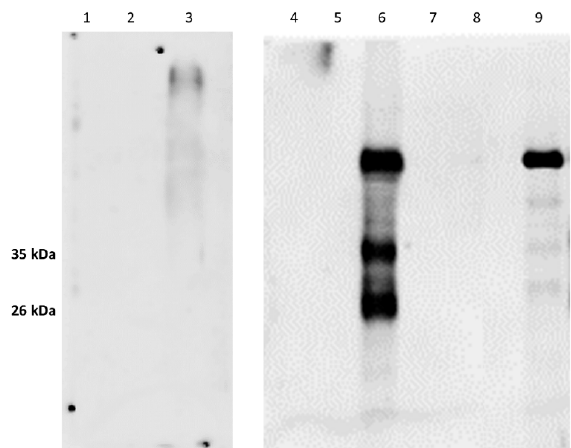
Figure 3. Results of WB analyses carried out with the anti-PrP MAb F89/160.1.5 on the pellets obtained after ultracentrifugation of brain tissue samples from one goat (lanes 1–3), as well as from a B. ceti -infected striped dolphin stranded along the Italian coast of Apulia (lanes 4–6) and from one lamb (lanes 7–9). The typical 35 kDa and 26 kDa PrP c bands are shown at lanes 3, 6 and 9 after ultracentrifugation, while lanes 2, 5 and 8 show the WB results obtained after proteinase K (PK) digestion, and lanes 1, 4 and 7 after treatment with deglycosydase F (original Western blot figure is in Figure S3).